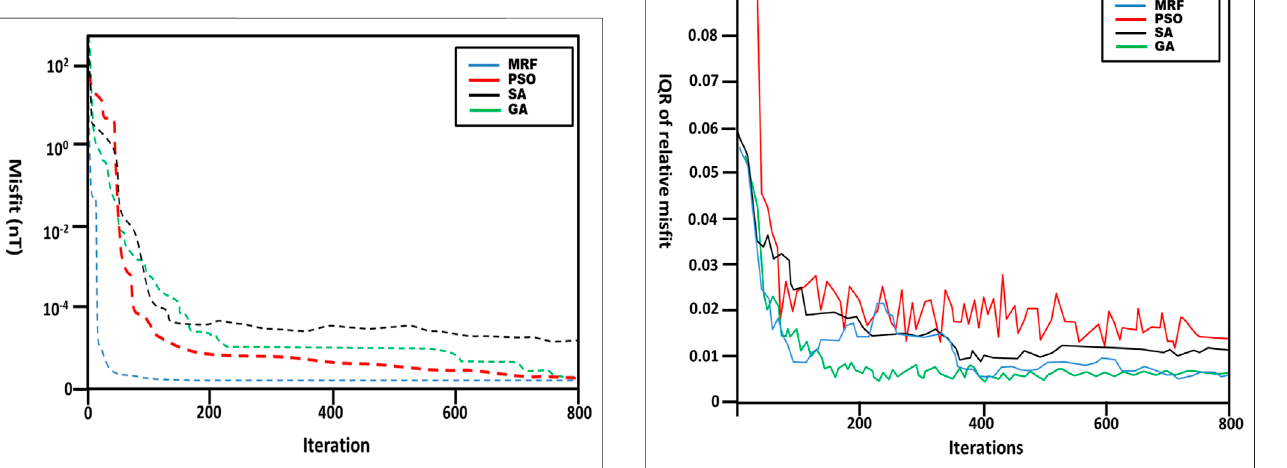
Frontiers in Earth Science |